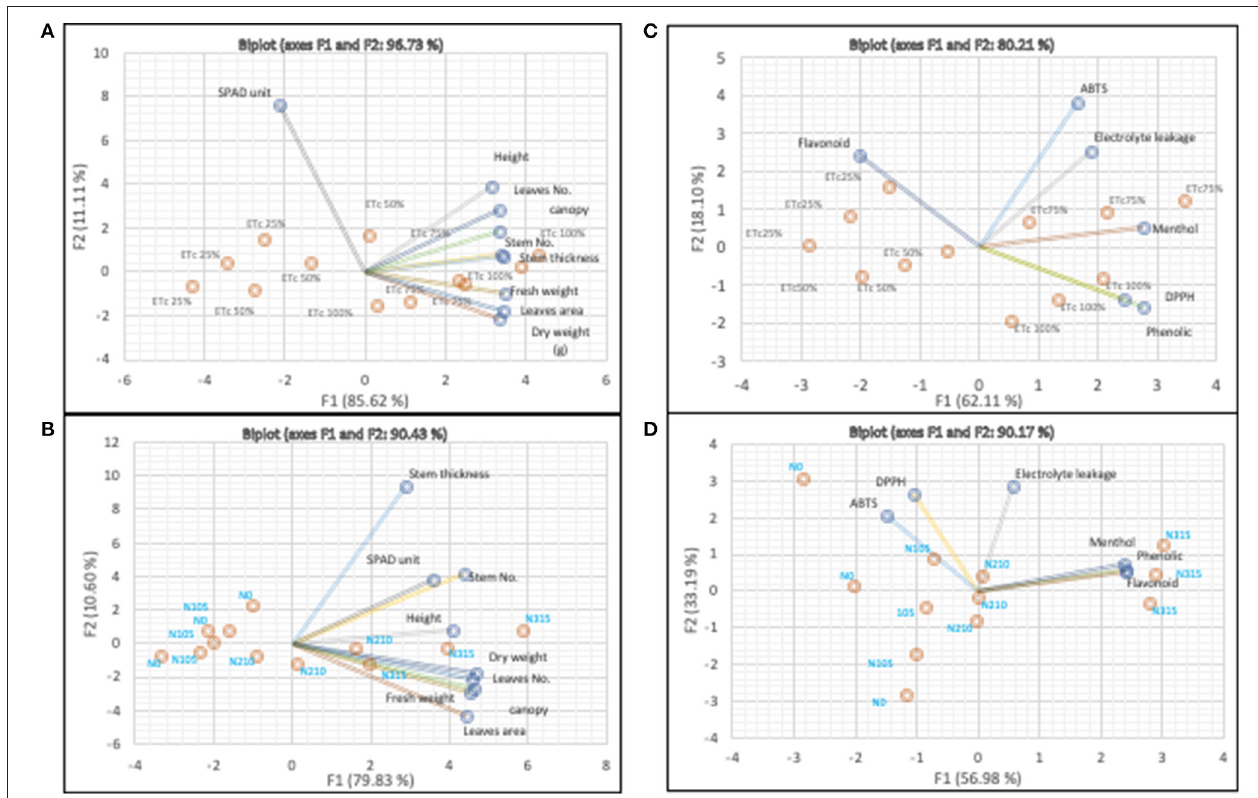
FIGURE 4 | Principal component analysis biplots of physical (A) and biochemical (C) responses of Mentha arvensis grown in the evaporative greenhouse with different water regimes and of physical (B) and biochemical (D) responses of Mentha arvensis grown in the evaporative greenhouse with different levels of nitrogen